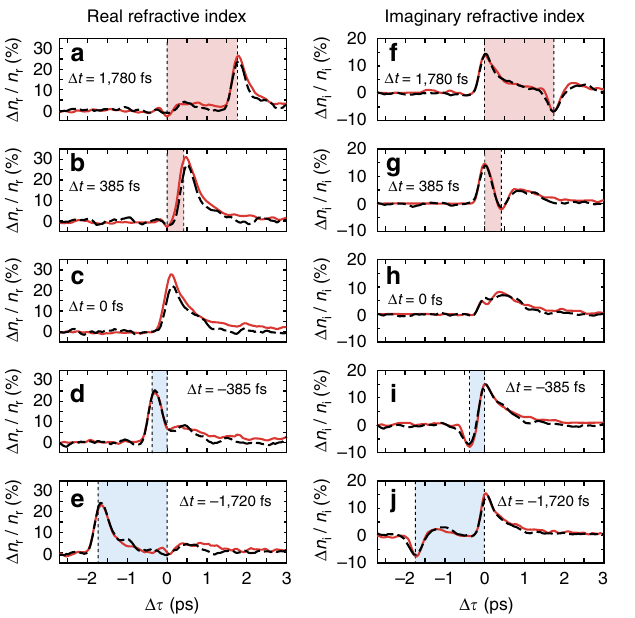
Figure 2 | Dynamic change in the optical response of AZO thin films triggered by two-colour excitation. Percentage change of the real ( a – e ) and imaginary ( f – j ) part of the refractive index as a function of the delay D t between the ultraviolet pump and the infrared probe pulses. Multiple vertical plots are shown, for different delay D t between the ultraviolet and the NIR pump pulses. Shaded areas indicate whether the ultraviolet pump, which is used as time reference, precedes (light blue) or follows (light red) the NIR pump. Overlapping the results obtained by simultaneous two-colour pumping (red curves), we plot the computed change in refractive index calculated by the algebraic summation of the results obtained from experiments with separate ultraviolet and NIR pump pulses (black dashed curves). The probe, the NIR and the ultraviolet pump wavelengths were set to 1,300nm, 787nm and 262nm, respectively. The probe intensity was low: I p C 200MWcm (cid:2) 2 , while the pump fluences were F ultraviolet ¼ 5mJcm (cid:2) 2 and F NIR ¼ 14mJcm (cid:2) 2